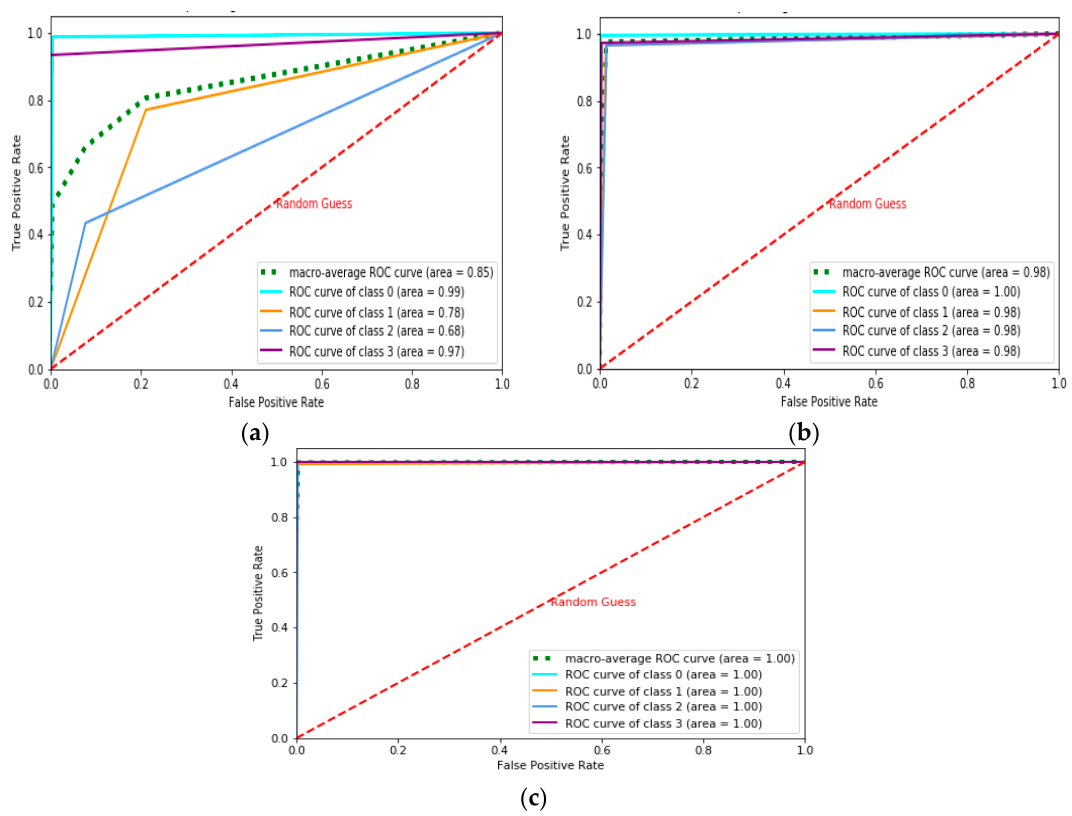
Figure 4. Multiclass AUC-ROC curve for MLP model with four hidden layers for: ( a ) N h = 30, ( b ) N h = 50, ( c ) N h = 80.